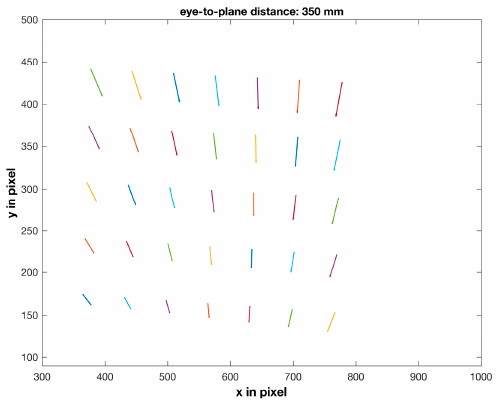
Figure A2. Map of disparities for a target plane placed at 350 mm from the observer.